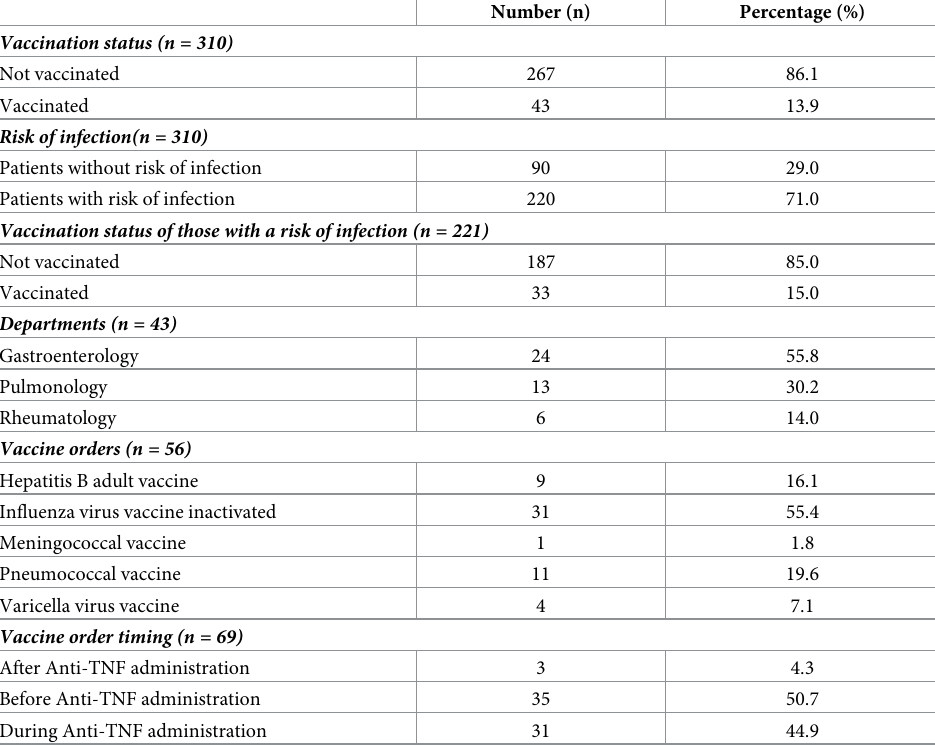
Table 2. Results of institutional vaccines prescribing by physicians in patients receiving Anti-TNFs.